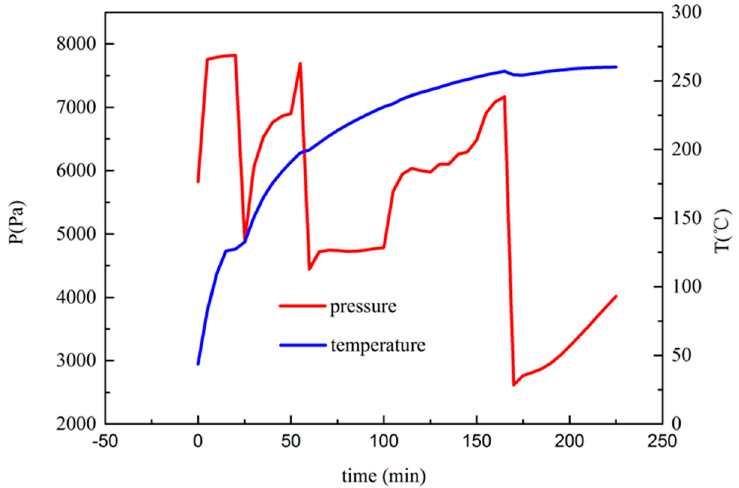
Figure 9. Variation of temperature and pressure during the desorption process.